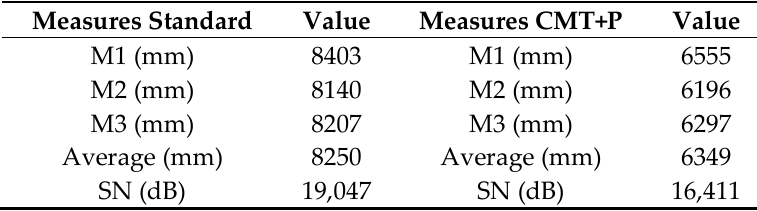
Table 4. Bead width values obtained in the confirmation experimental tests.